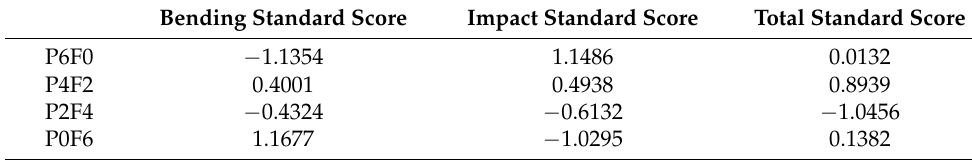
Table 2. Composite material standard